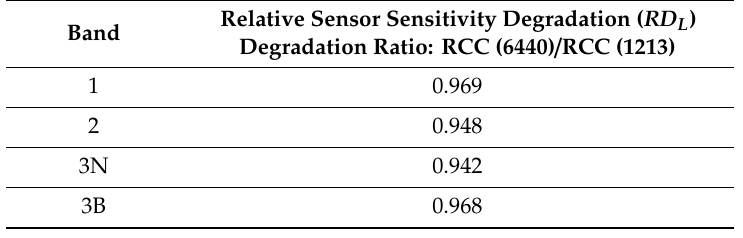
Table 1. Relative sensor sensitivity degradation ( RD L ), which is the degradation ratio of RCCs for VNIR bands from 2003 (DSL = 1213) to 2017 (DSL = 1213) by lunar calibration using the SP model